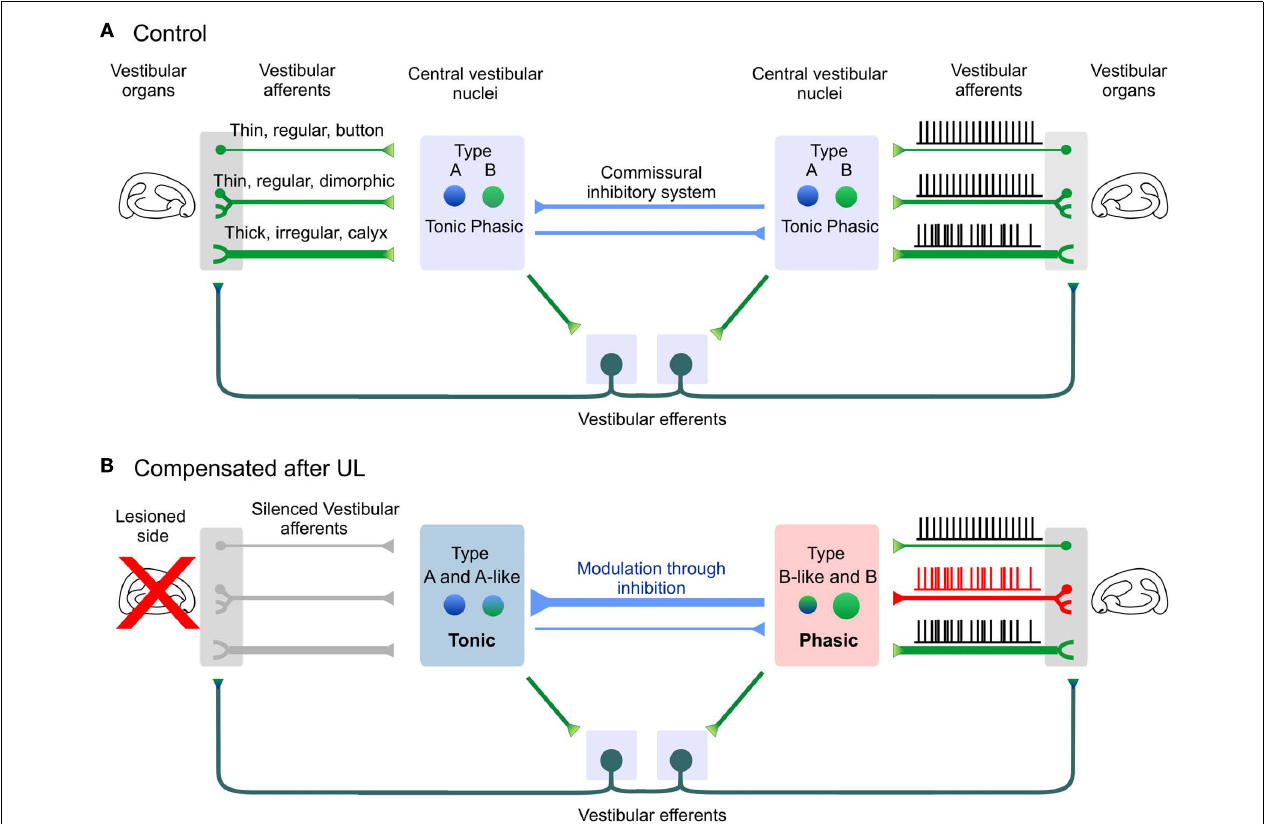
One month after UL, membrane properties of 2˚VN are bilaterally modified.The ipsilesional side is dominated by tonic, type A and type A-like neurons. On the contralesional side, both the vestibular afferents and central vestibular neurons evolve toward more phasic properties. Modifications of the vestibular afferents through the efferent pathway are hypothesized from Sadeghi et al. (2007b). Note that irregular dimorphic afferents were omitted for sake of